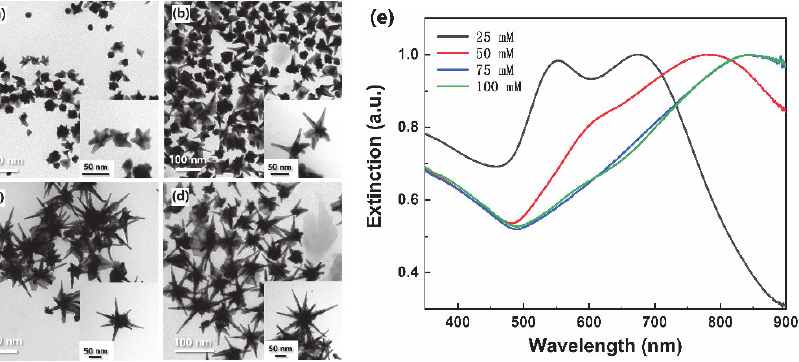
Figure 1. TEM images of nanostructures synthesized with different LSB concentrations: 25 mM ( a ), 50 mM ( b ), 75 mM ( c ), and 100 mM ( d ), inset images were detailed nanostructures geometries of independent particles, and ( e ) extinction spectra of the nanostructures.